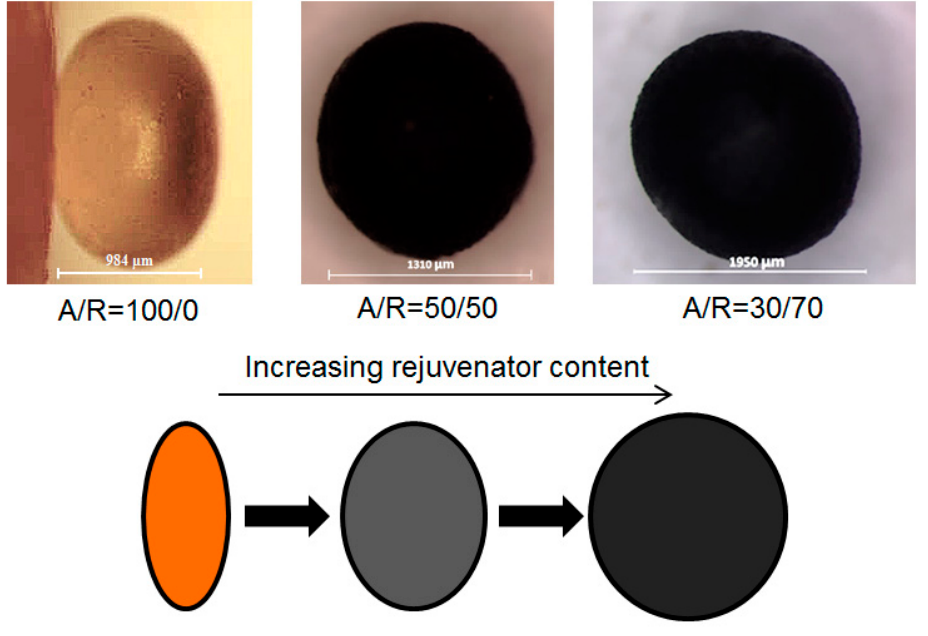
Figure 4. Microscopic images of capsules and the trend with alginate/rejuvenator (A/R) ratio. Table 2. Calcium alginate capsules with different alginate/rejuvenator ratios.